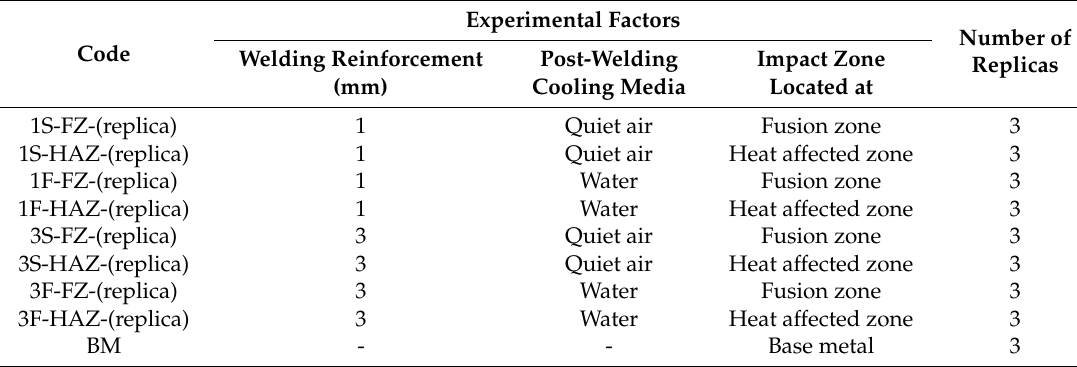
Table 2. Coding used for the Charpy impact energy test specimens.